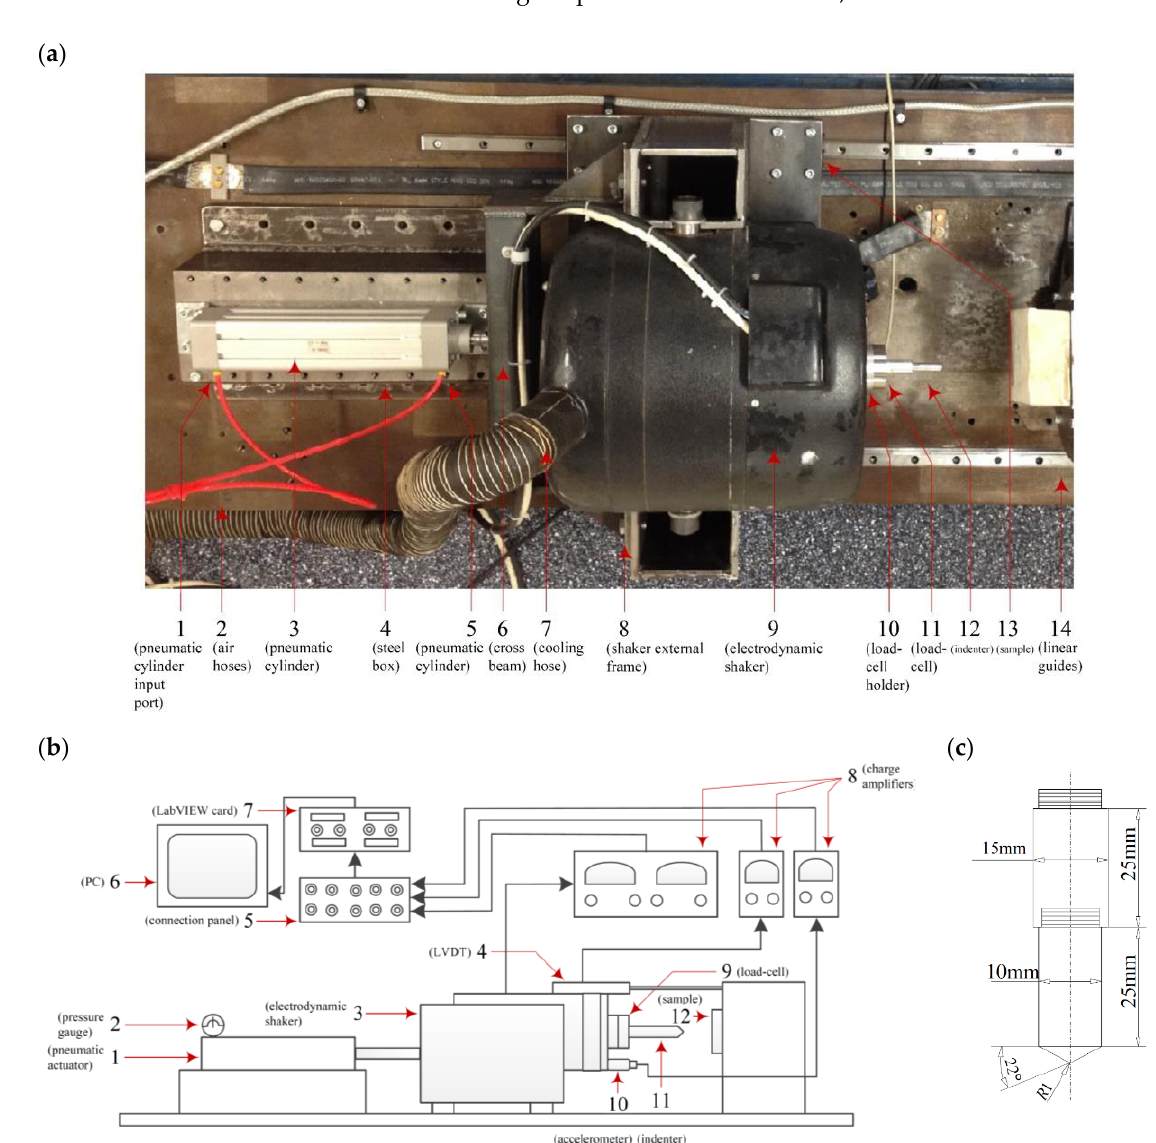
Figure 1. ( a ) Top view of the CADR experimental apparatus used for the present work. ( b ) Schematic of ( a ). ( c ) Geometry of the indenter.